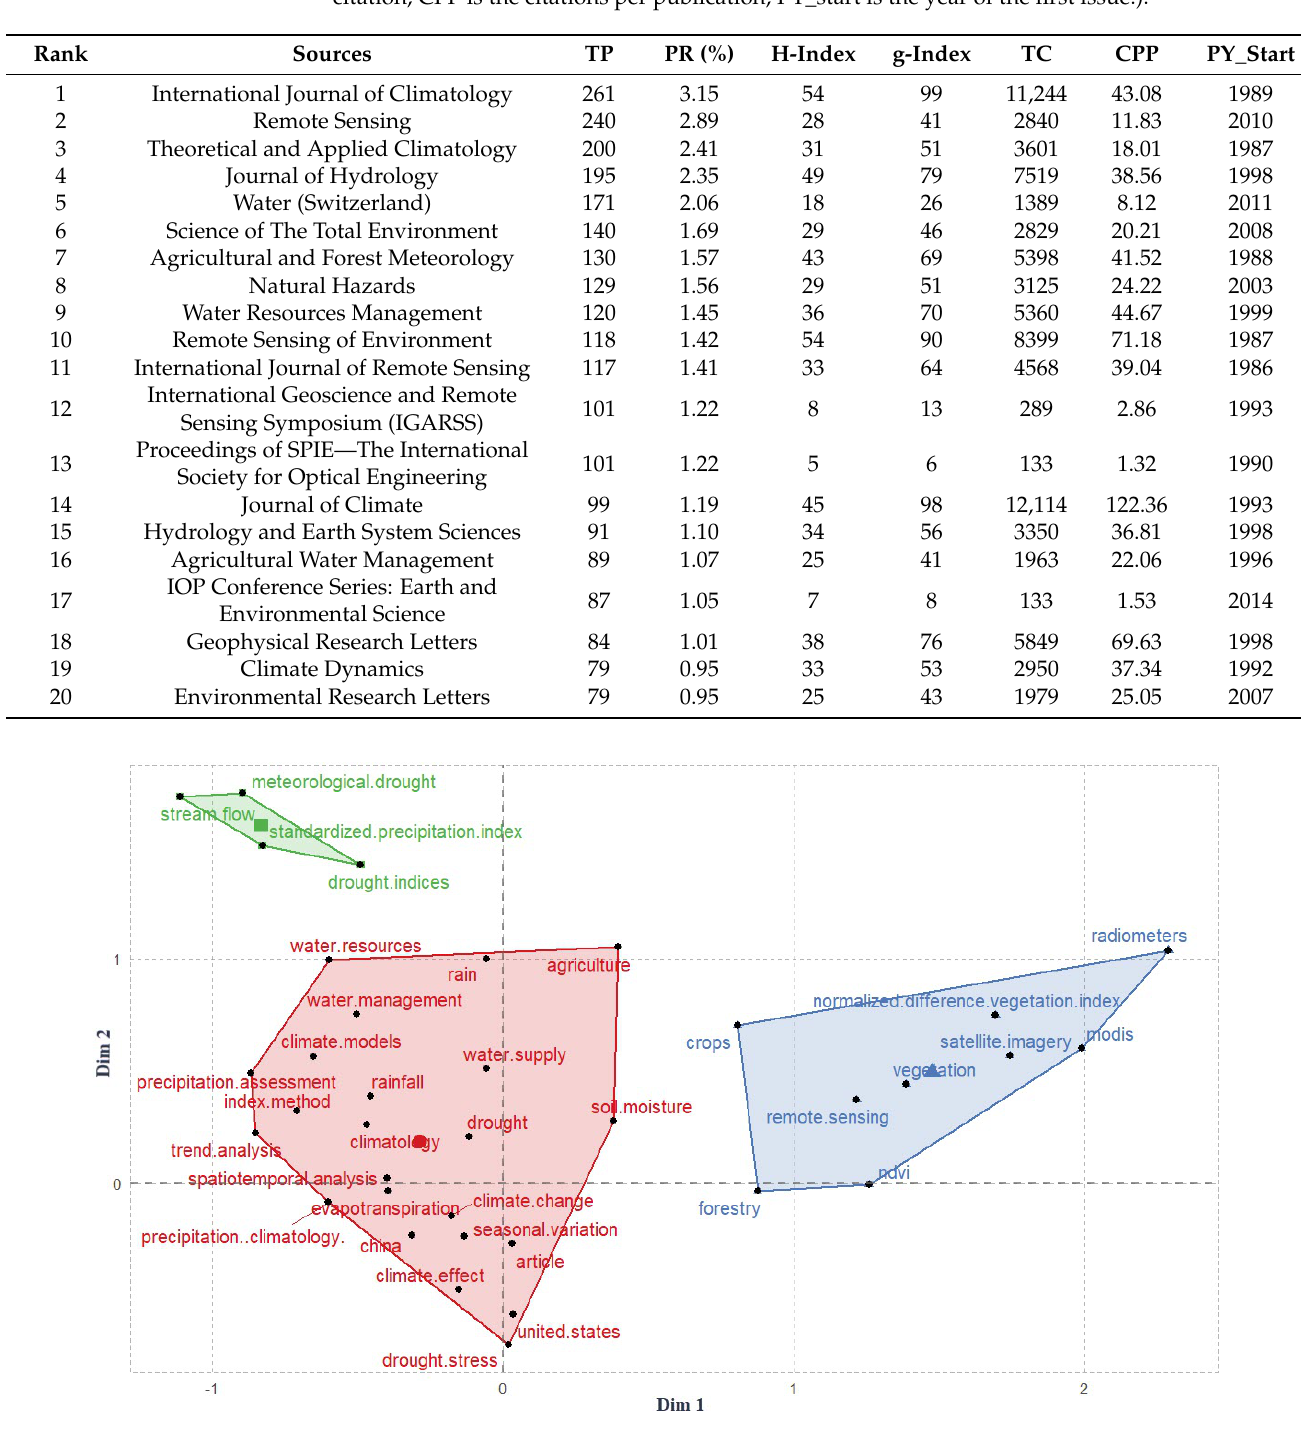
Figure 7. Conceptual structure map of keywords plus in DI studies.